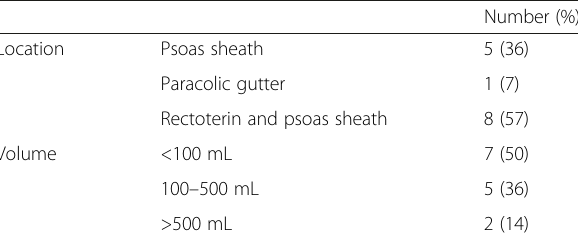
Table 3 Distribution of patients ( n = 14) according to hematoma location and volume indicated by ultrasonography